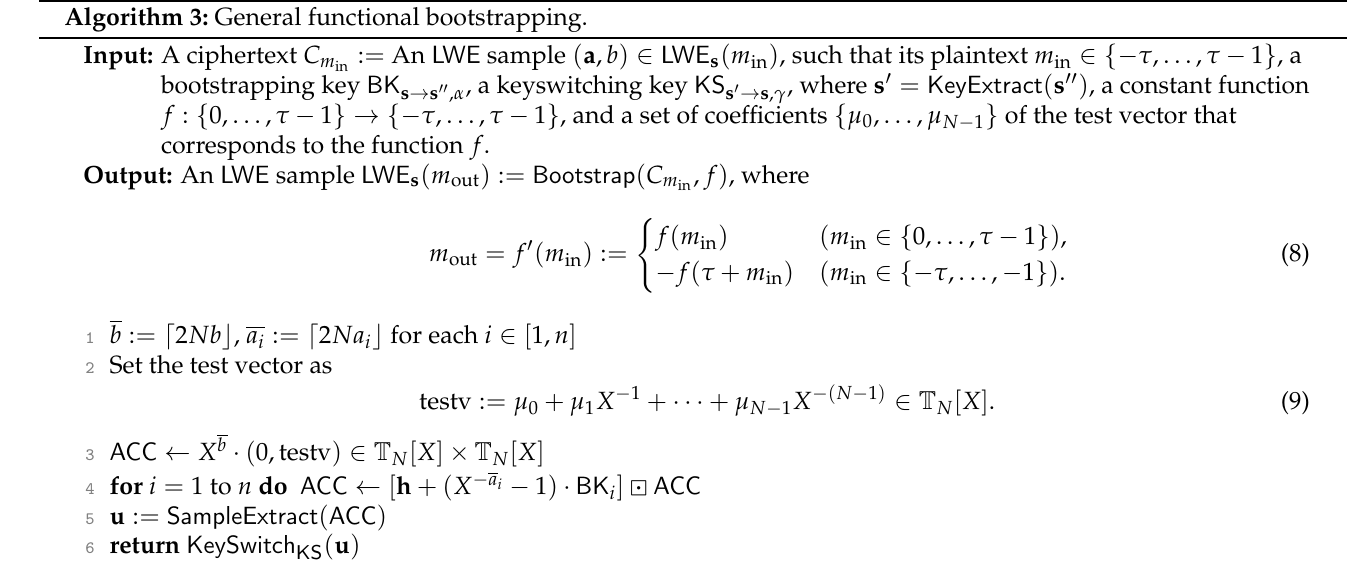
Algorithm 3: General functional bootstrapping.